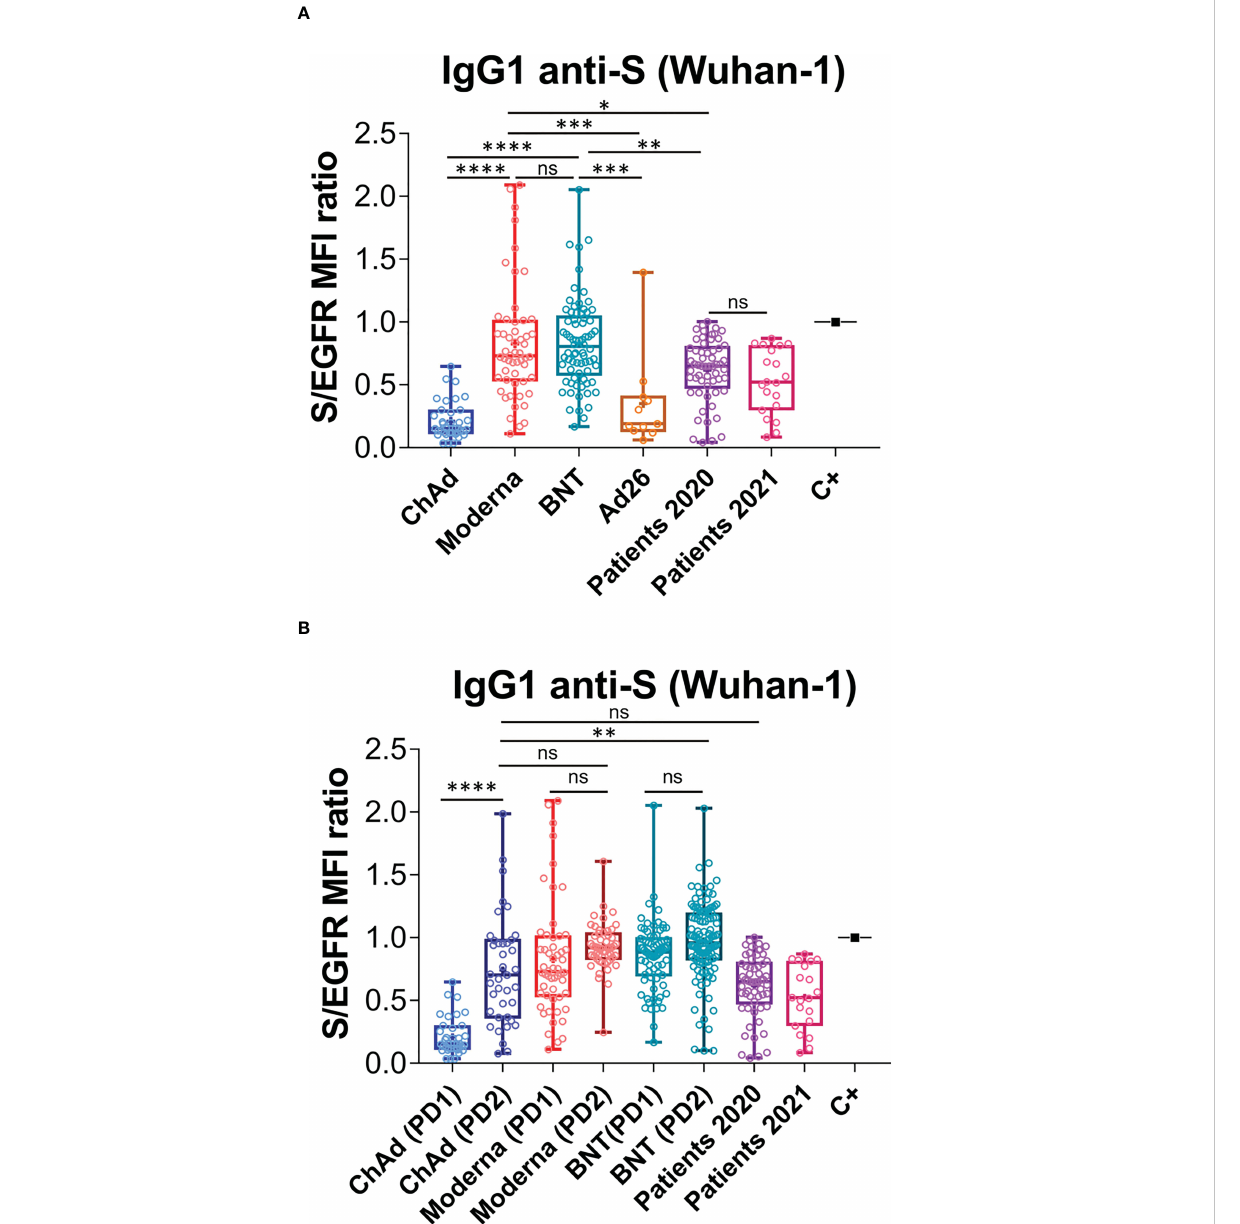
FIGURE 1 Generation of anti-S protein antibodies in response to the fi rst and second priming-booster doses of different vaccines. (A) Generation of antibodies against the S protein of the Wuhan strain 3 weeks (BNT) or 4 weeks (Moderna, ChAd and Ad26) after the fi rst priming dose of vaccine to previously uninfected individuals. The ratio of the mean fl uorescence intensities (MFI) of anti-S staining and anti-EGFR staining was calculated for each serum sample and normalized to the value of the positive control (C+) sample. All sera were used at a 1:50 dilution. Box and whiskers plots to represent minimum and maximum values as well as the median, and the mean (the mean with a cross) is shown. * p <0.05; ** p <0.01; *** p <0.001; **** p <0.0001; ns, not signi fi cant (one-way ANOVA test). (B) Generation of antibodies against the S protein of the Wuhan variant strain 3 weeks (BNT) or 4 weeks (Moderna, ChAd and Ad26) after the fi rst, priming, dose of vaccine and 4 weeks (all vaccines) after the second, booster dose of vaccine. The ratio mean fl uorescence intensities (MFI) of anti-S staining and anti-EGFR staining was calculated for each serum sample and normalized to the value of the positive control (C+) sample. All sera were used at a 1:50 dilution. Box and whiskers plots to represent minimum and maximum values as well as the median, and the mean (the mean with a cross) are shown. The number of samples for each vaccine is shown in the graph. ** p <0.01; **** p <0.0001; ns, not signi fi cant (one-way ANOVA